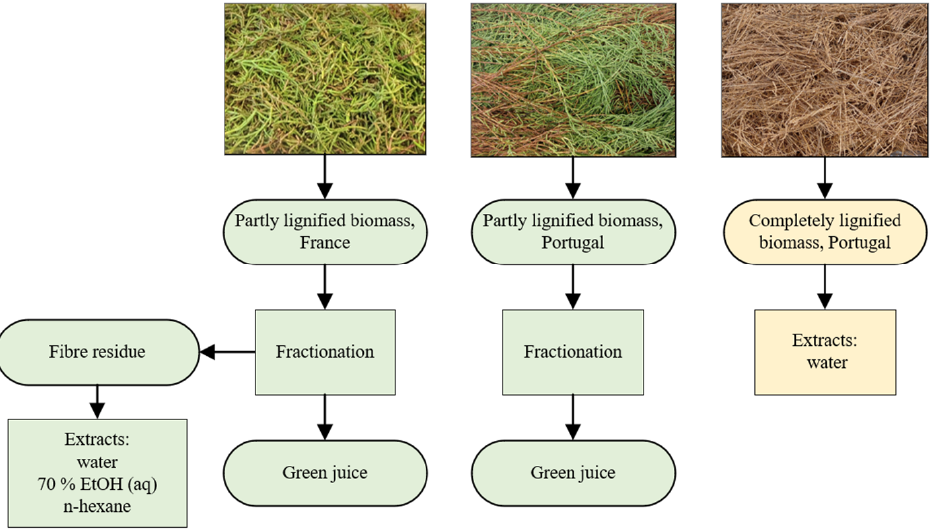
Figure 1. Origin of Salicornia ramosissima biomass batches and considered fractions and botanical extracts. Fresh biomass batches were first fractionated into green juice and fibre residue fractions using a screw press. The green juice fractions were centrifuged at 4000 rpm for 20 min, filtered using a Whatman filter (GE Healthcare), and freeze-dried using a ModulyoD freeze dryer (Thermo Scientific, Waltham, MA, USA). The fibre residue was dried overnight at a 60 ◦ C fan oven, homogenised using a knife-miller to achieve a particle size of less than 2 mm, and stored at room temperature